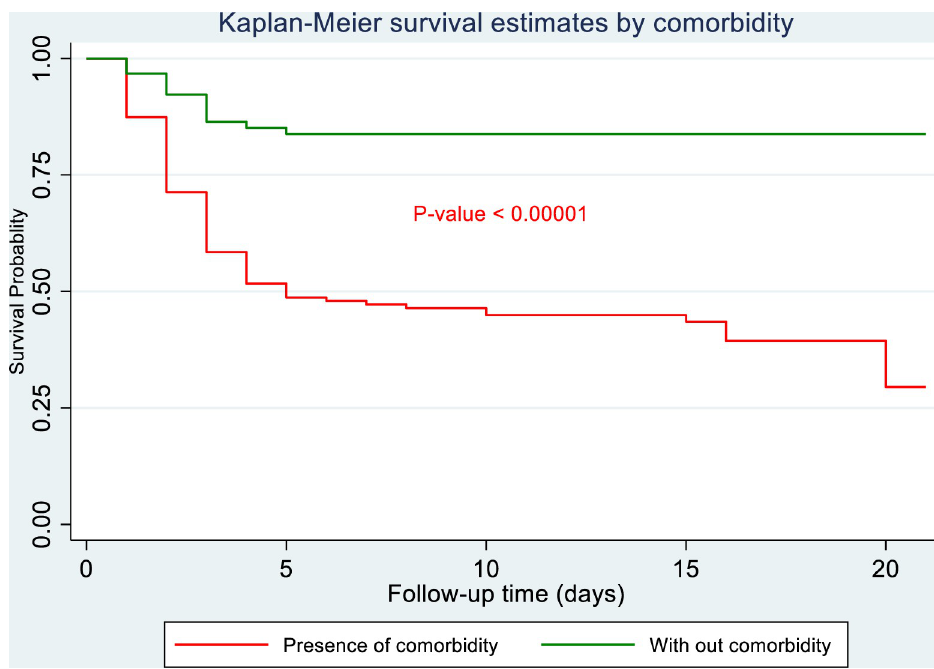
Fig 4. Kaplan-Meier survival curve of newborns with asphyxia by comorbidity in Northwest Ethiopia selected hospitals from November 1, 2018, to November 1, 2019.